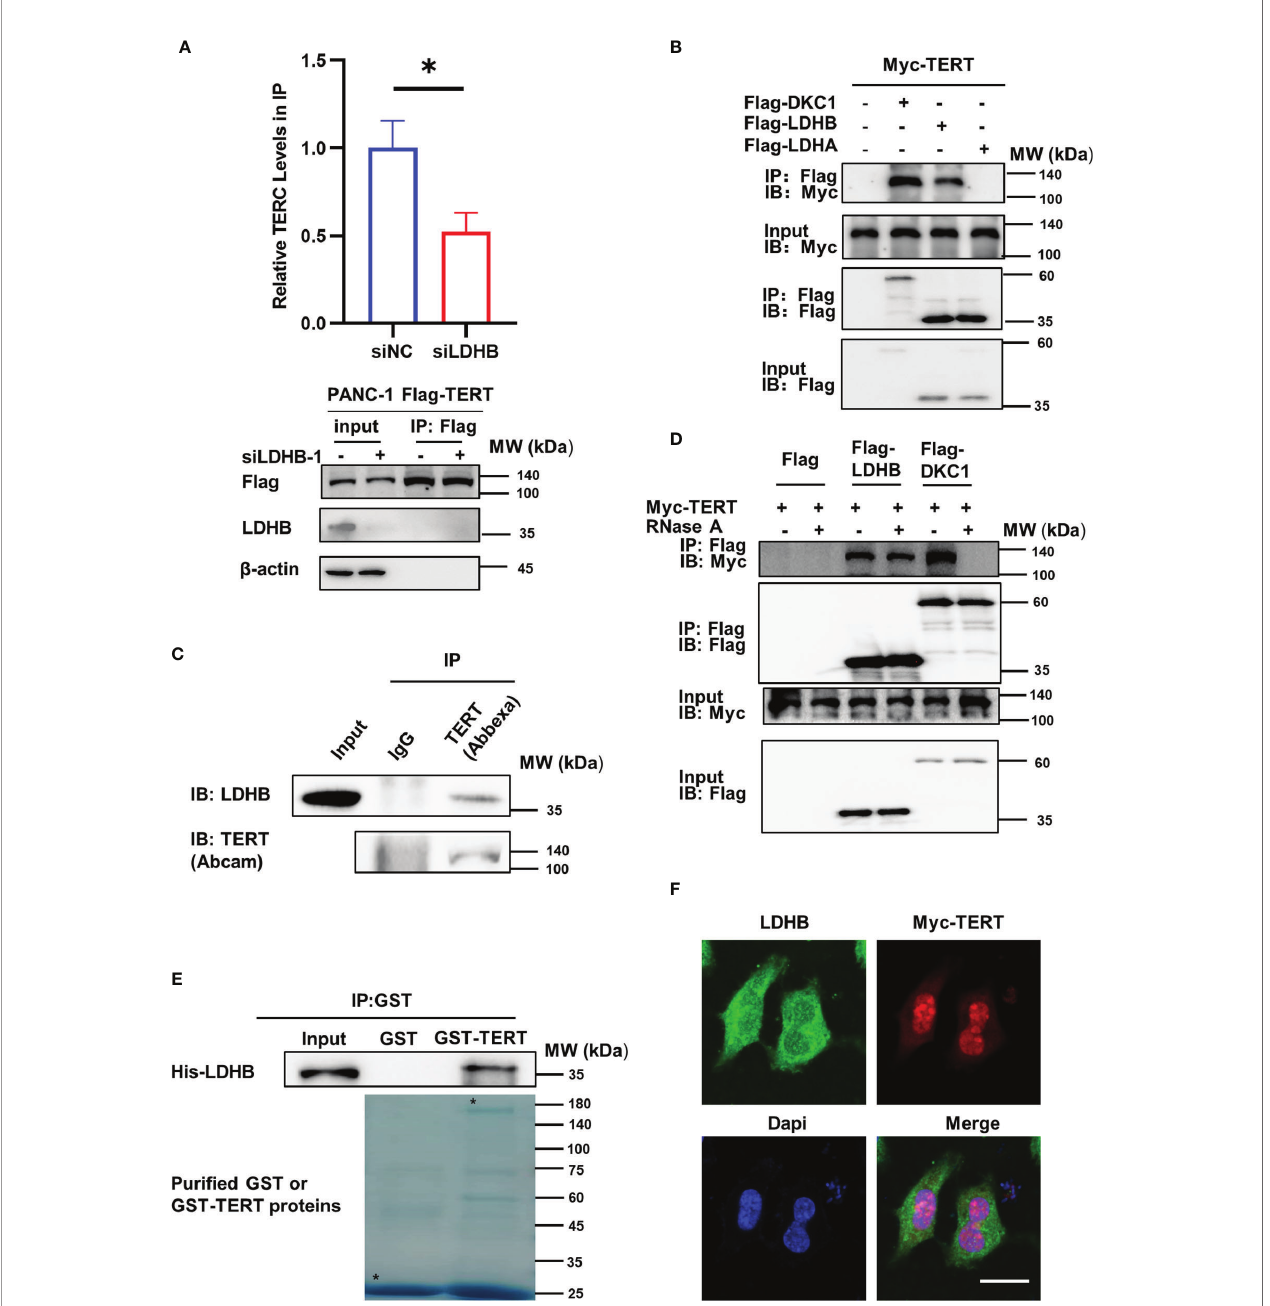
FIGURE 2 | LDHB interacts with TERT and regulates interaction between TERT and TERC. (A) PANC-1 Flag-TERT cells were transiently transfected with LDHB siRNA-1 or control siRNA and immunoprecipitated with anti-Flag followed by immunoblot analysis for Flag-TERT, LDHB and b -actin expression. Relative TERC levels in IP lysates were determined by qRT-PCR. Data are representative of three independent experiments (mean ± SD of two technical replicates. * P < 0.05). (B) 293T cells were transiently transfected with Myc-TERT and Flag-LDHB, Flag-LDHA or Flag-DKC1 (as a positive control), and lysates were immunoprecipitated with anti- Flag. Flag antibody was used for immunoblotting (IB) to detect LDHB, LDHA and DKC1, and Myc antibody was used to detect TERT expression. (C) PANC-1 cell lysates were immunoprecipitated with IgG or anti-TERT (Abbexa) and immunoblotted with indicated antibodies. (D) HEK293T cells were transiently transfected with Myc-TERT and Flag-LDHB or Flag-DKC1 plasmids. Lysates were treated with or without RNase A (0.1mg/ml). Anti-Flag was used for IP. LDHB and DKC1 were detected by IB with Flag antibody, and TERT expression was detected by Myc antibody. (E) Glutathione-Sepharose beads bound with GST-TERT or GST were incubated with puri fi ed His-tagged LDHB. After washing the beads, the bound proteins were examined by immunoblot with anti-His antibody. Puri fi ed proteins were examined by Coomassie brilliant blue staining after SDS-PAGE. Asterisks indicate the positions of the expected full-length fusion proteins. (F) PANC-1 cells were transiently transfected with Myc-TERT plasmid. The localization of LDHB and TERT were detected by immuno fl uorescence. Scale bar, 20 m